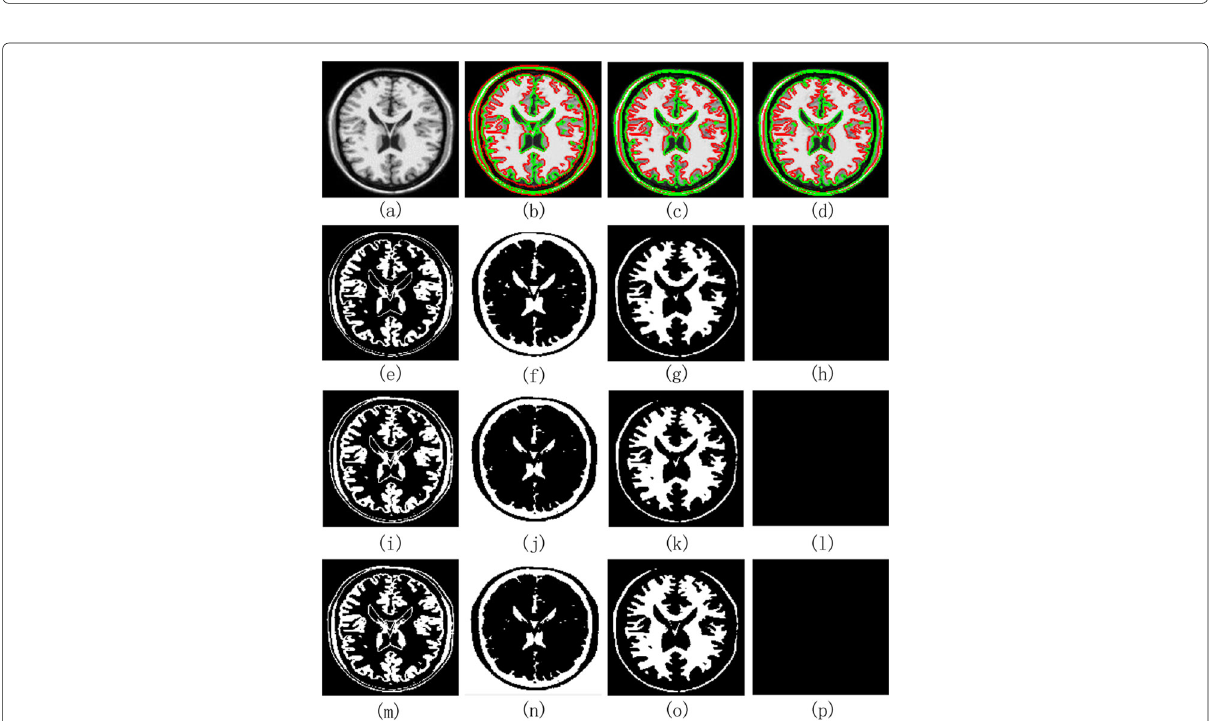
Fig. 6 Three-phase segmentation for a CT image slice of brain. a The input CT image slice of brain. b The segmentation of original Vese-Chan method. c The segmentation of TV regularization method. d The segmentation of our method. e – h Different regions obtained via the original Vese-Chan method. i – l Different regions obtained via TV regularization method. m – p Different regions obtained via our